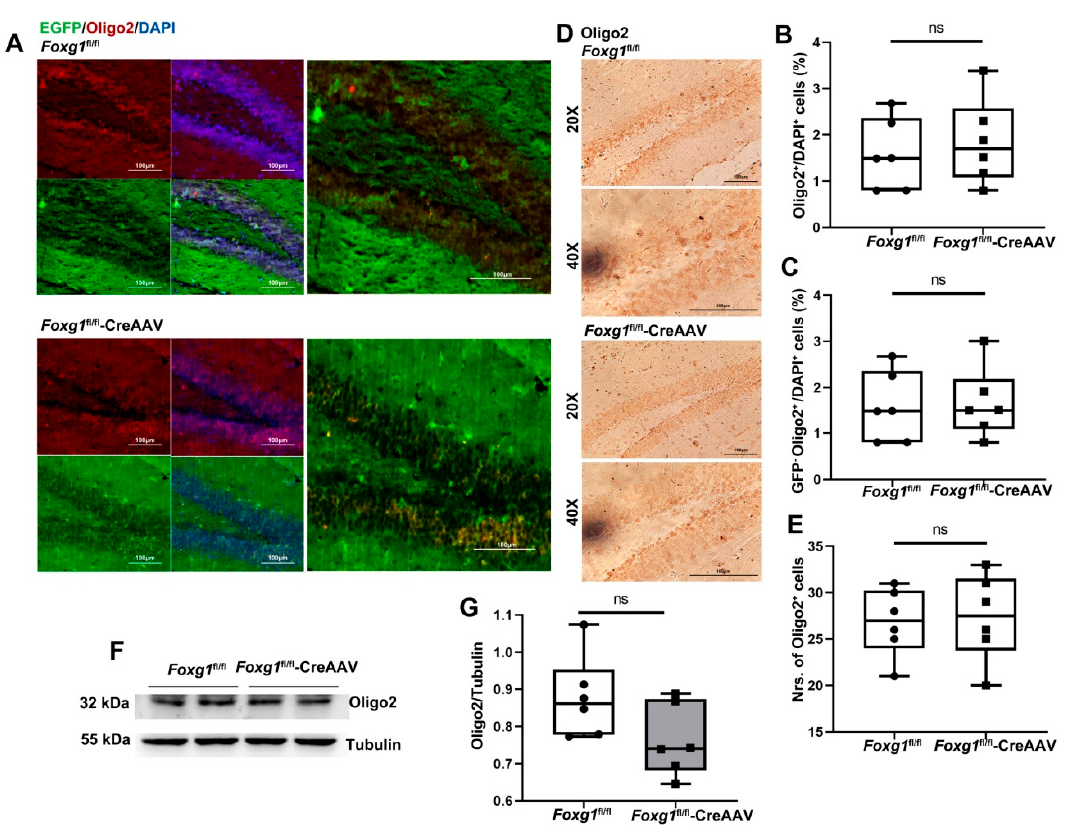
Figure 8. FOXG1 has no ability to induce the production of oligodendrocytes in adult hippocampal DG of the Foxg1 genotype mice. ( A ) Expression patterns of oligodendrocytes in the hippocampal DG of Foxg1 genotype mice were assessed with immunofluorescence. Red = Oligo2; Green = EGFP-labeled FOXG1; Blue = DAPI. Scale bars = 100 μ m. ( B ) Levels of total oligodendrocytes in adult hippocampus are showed as %Oligo2 + /DAPI + cells. ( C ) Levels of endogenous oligodendrocytes in adult hippocampus are showed as %GFP − Oligo2 + /DAPI + cells. ( D ) Expression patterns and ( E ) qualification of total oligodendrocytes in adult hippocampus were studied with immunohischemisitry. Scale bars = 100 µ m. ( F , G ) Hippocampal lysates of the two genotype mice were immunoblotted using an antibody against Oligo2. Tubulin was used as the loading control. Values are expressed as means ± S. E. M. n = 6/group. ns—not significant.